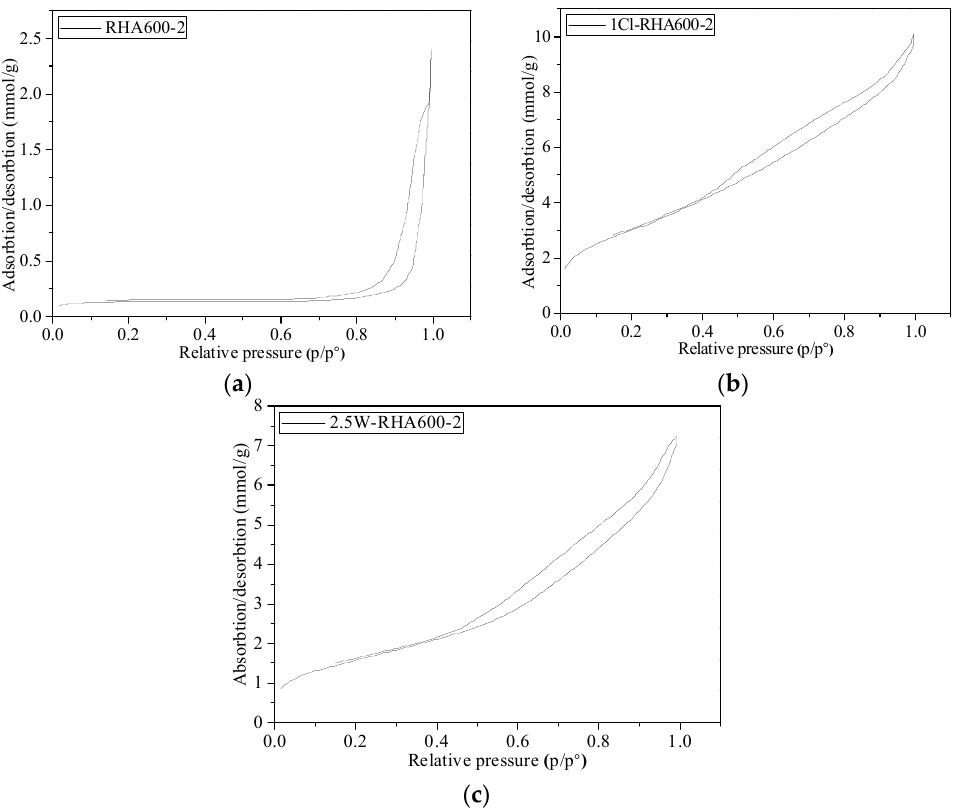
Figure 1. Nitrogen adsorption ‒ desorption isotherm for ( a ) untreated RHA; ( b ) acid-treated RHA and ( c ) water-treated RHA.